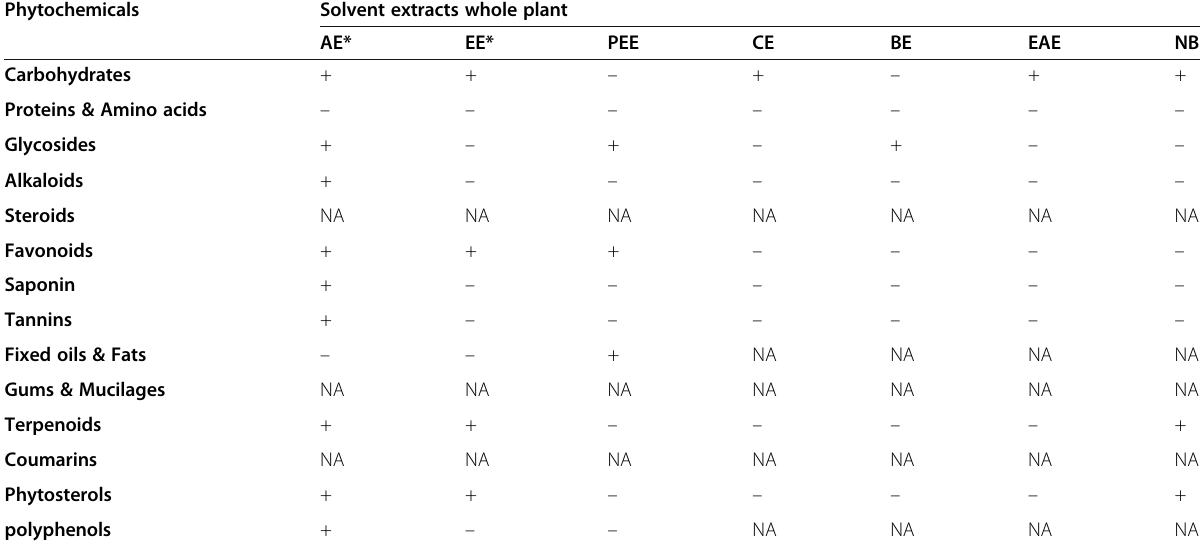
Table 2 Preliminary qualitative phytochemical screening of different solvent extracts on P. daemia whole plant Phytochemicals Solvent extracts whole